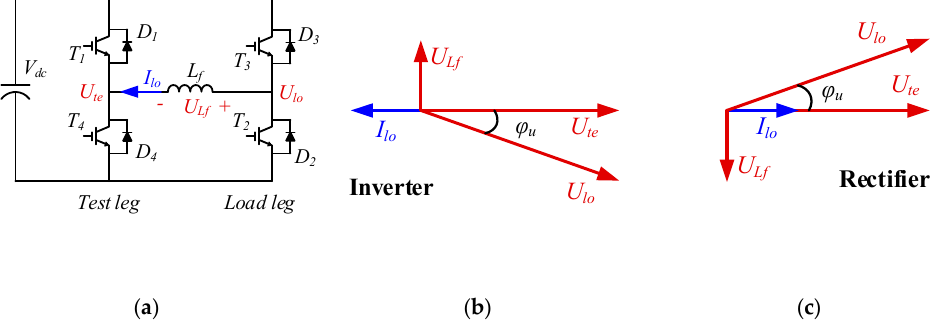
Figure 1. Configuration of H-bridge circuit and phasor diagram between test leg and load leg. ( a ) Single-phase H-bridge circuit. ( b ) Phasor diagram in the case of inverter mode. ( c ) Phasor diagram in the case of rectifier mode.